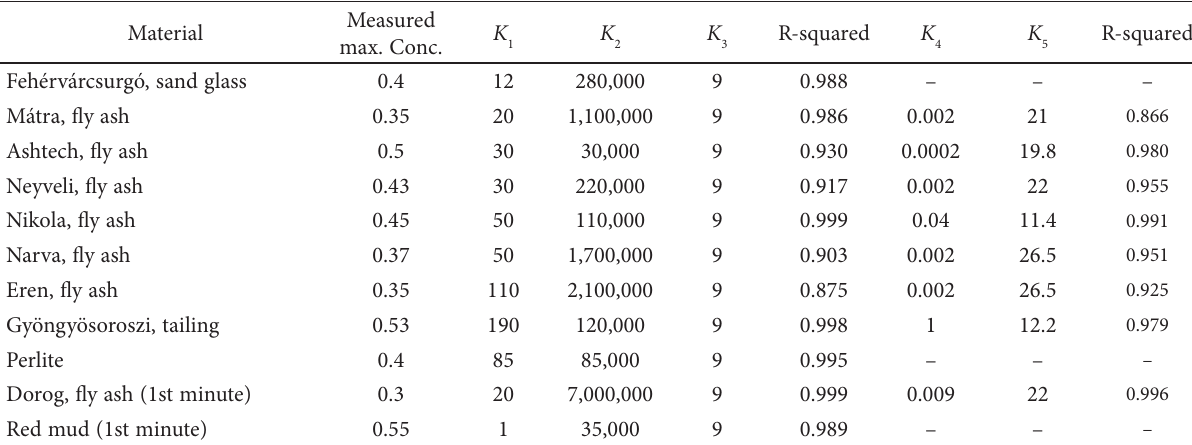
Table 15. Collected constants comparison of all the tested material Measured Material max.